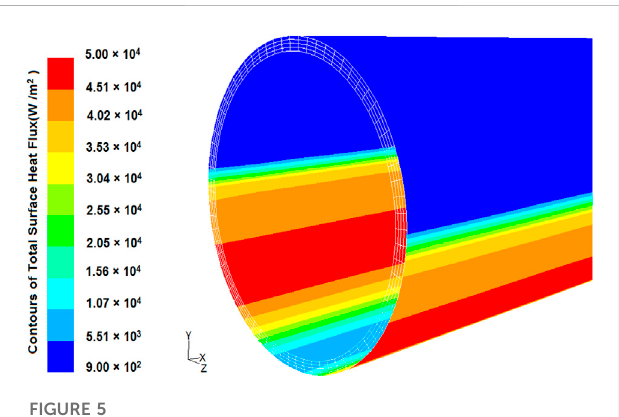
FIGURE 5 Heat fl ux distribution on the absorber tube surface (current study).